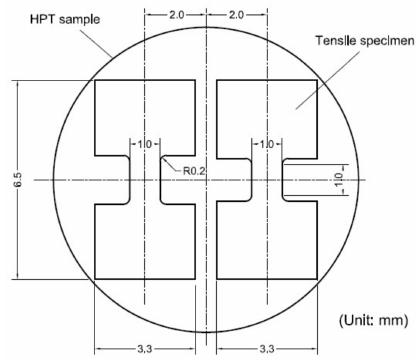
Figure 2. Sample size of micro-tensile